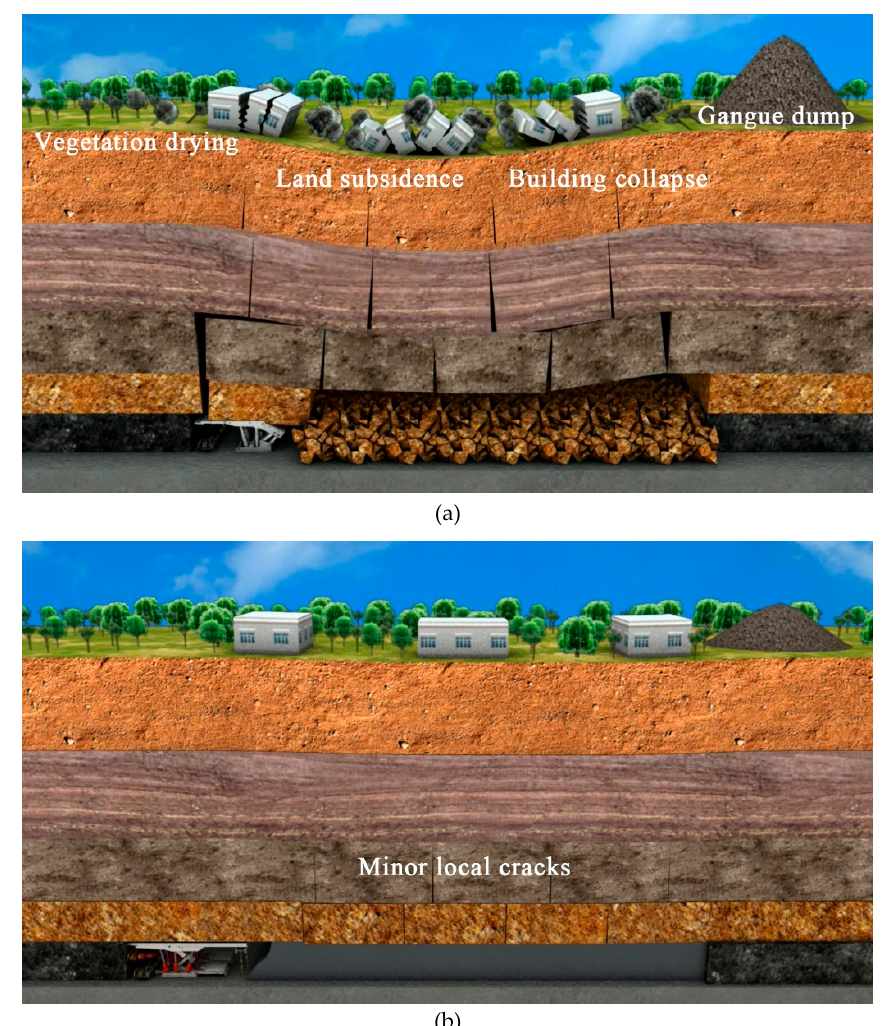
Figure 1. Schematic diagram of the influences of coal mining on the environment. ( a ) Caving mining; ( b ) Backfilling mining.